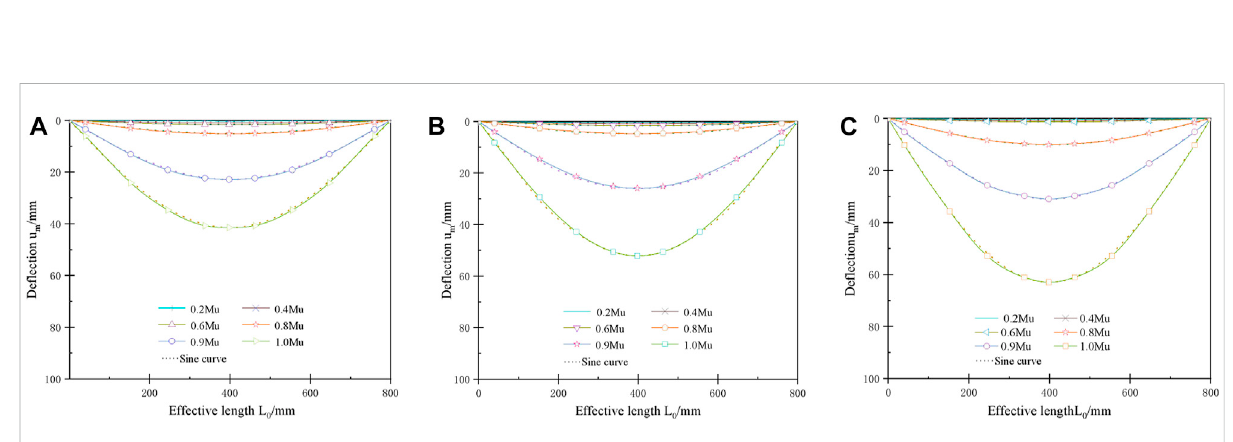
FIGURE 11 De fl ection curves of three types of pipe roof (A) Grouting pipe roof (B) Grouting pipe roof with reinforcement bundles; and (C) pipe roof with casing pipe.